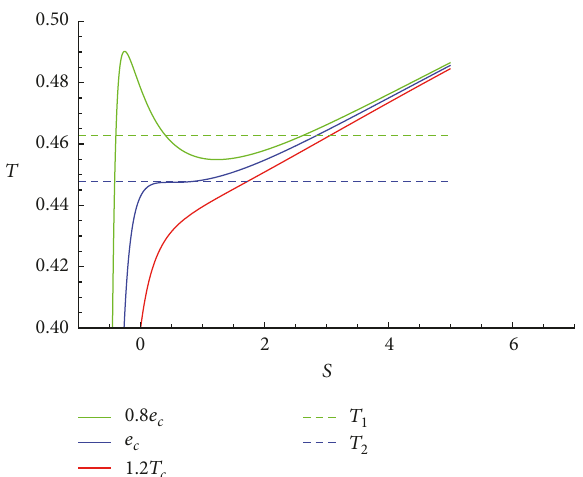
Figure 3: Relations between temperature and thermal entropy for different 𝑒 with 𝑞 = 0.05 .